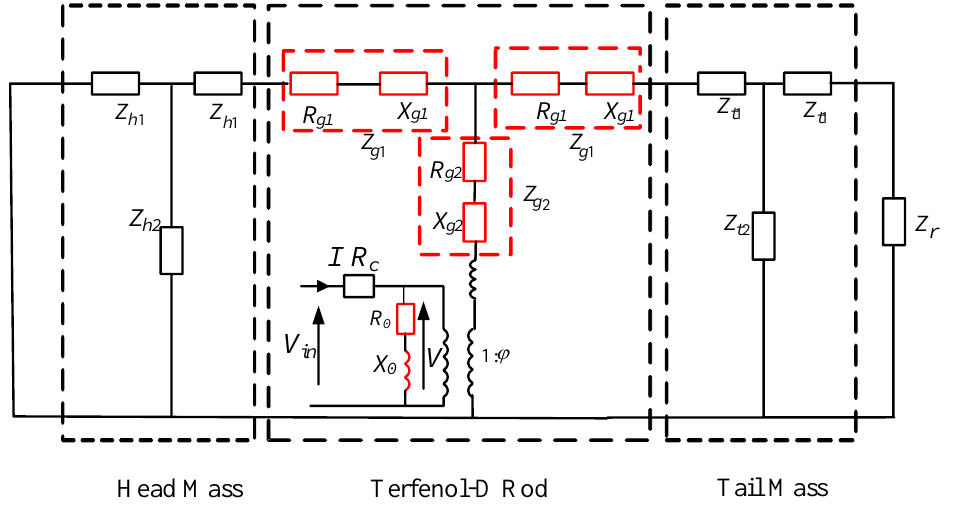
Figure 8. The equivalent PWM circuit of the Tonpilz Terfenol-D transducer considering material losses. The impedance of the mechanical part is changed from pure reactance to resistance and reactance, the real part of the inductance of the magnetic circuit part is the inductance representing the energy storage, and the imaginary part is the resistance representing the magnetic loss. The imaginary part of the permeability µ S (cid:48)(cid:48) is a negative value. The imaginary part of the inductance L (cid:48)(cid:48) calculated according 33 0 to Equations (14) and (21) is also negative. Therefore, the resistance R 0 obtained by converting the imaginary part of the inductance, representing the magnetic loss, is a positive resistance that varies with frequency. The imaginary part of the material characteristic parameters is eventually converted into the resistances of the PWM equivalent circuit, and, thus, it is expressed as the energy dissipation elements in the equivalent circuit of the giant magnetostrictive transducer. Therefore, the loss can be directly considered if the six characteristic parameters ( S H (cid:48) , S H (cid:48)(cid:48) , d (cid:48) , d (cid:48)(cid:48) , µ T (cid:48) , µ T (cid:48)(cid:48) ) of the giant 33 33 33 33 33 33 magnetostrictive transducer material under specific working conditions are